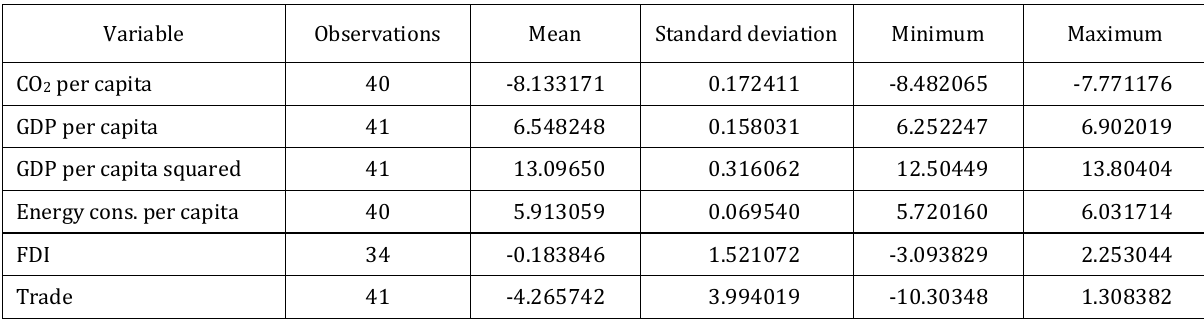
Table 1. Summary statistics of variables from 1970-2010 (source: author’s estimations) Variable